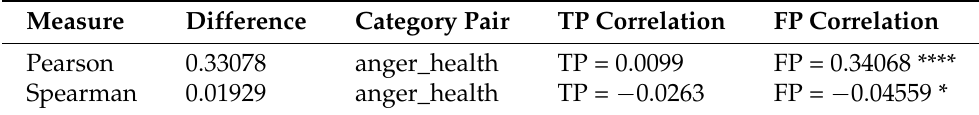
Table 29. Anger and Health in Medium.